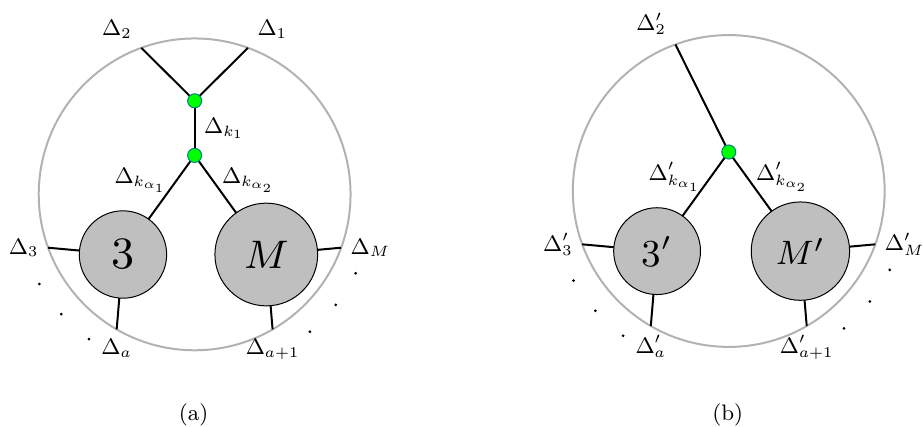
or ∆ 0 is inserted i i